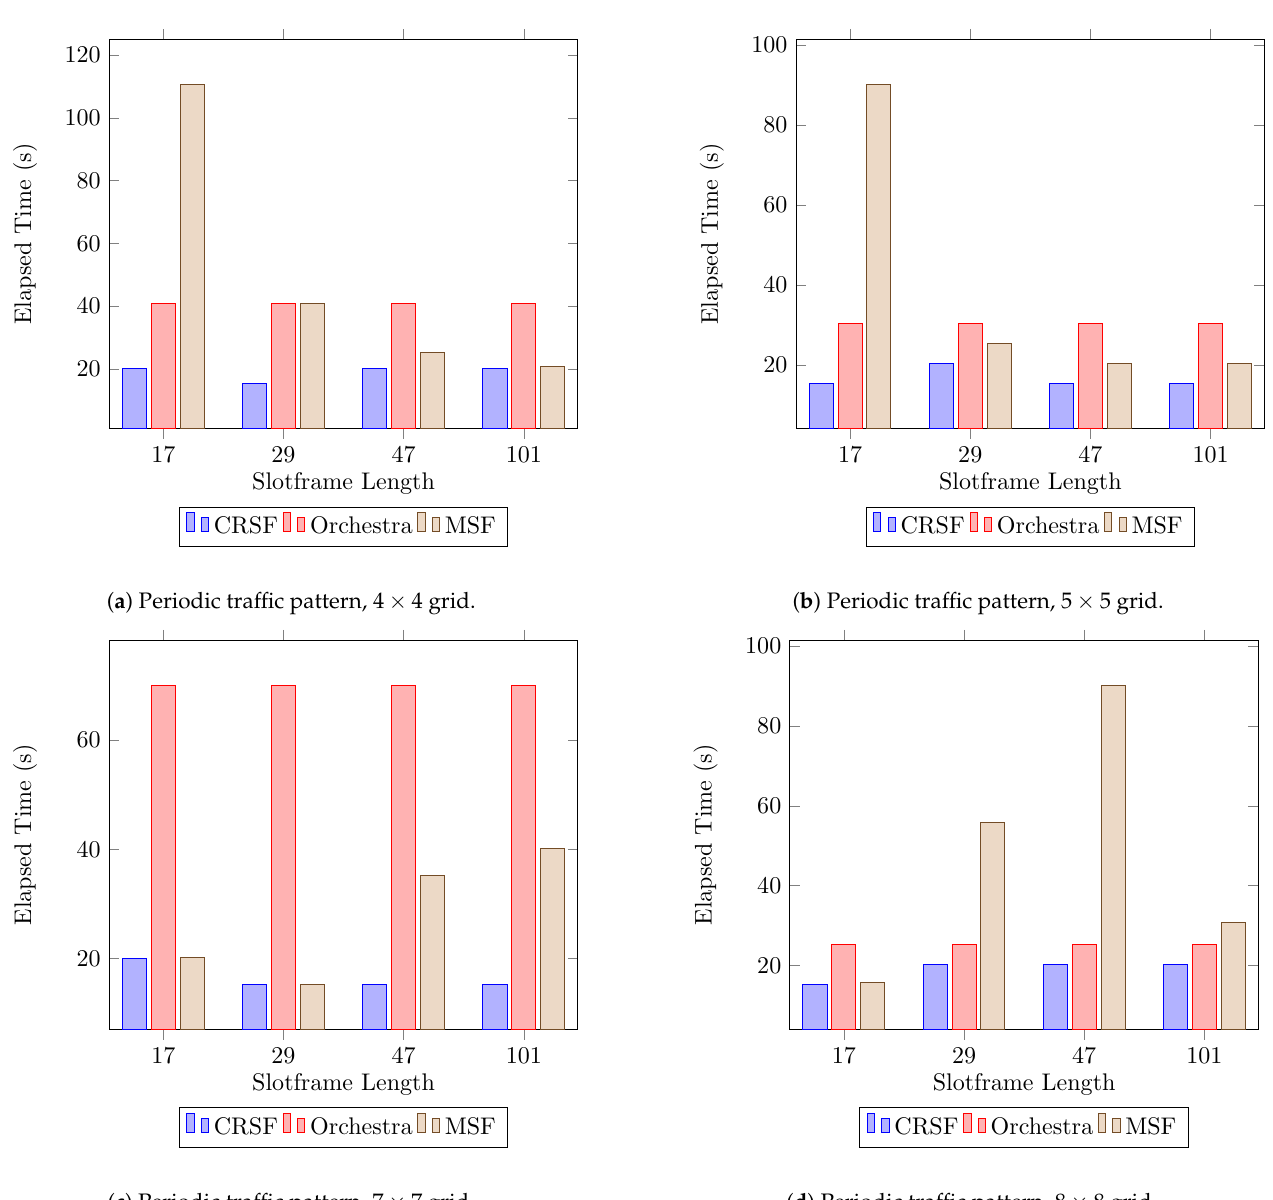
( c ) Periodic traffic pattern, 7 × 7 grid. ( d ) Periodic traffic pattern, 8 × 8 grid. Figure 8. Results for the time elapsed for the first packet to be scheduled using a periodic traffic pattern. Lower is